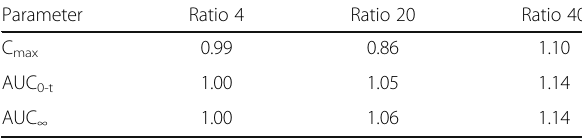
Table 3 Effect of ethanol on pharmacokinetic parameters of Remoxy (data from reference (de Kater et al. 2008))